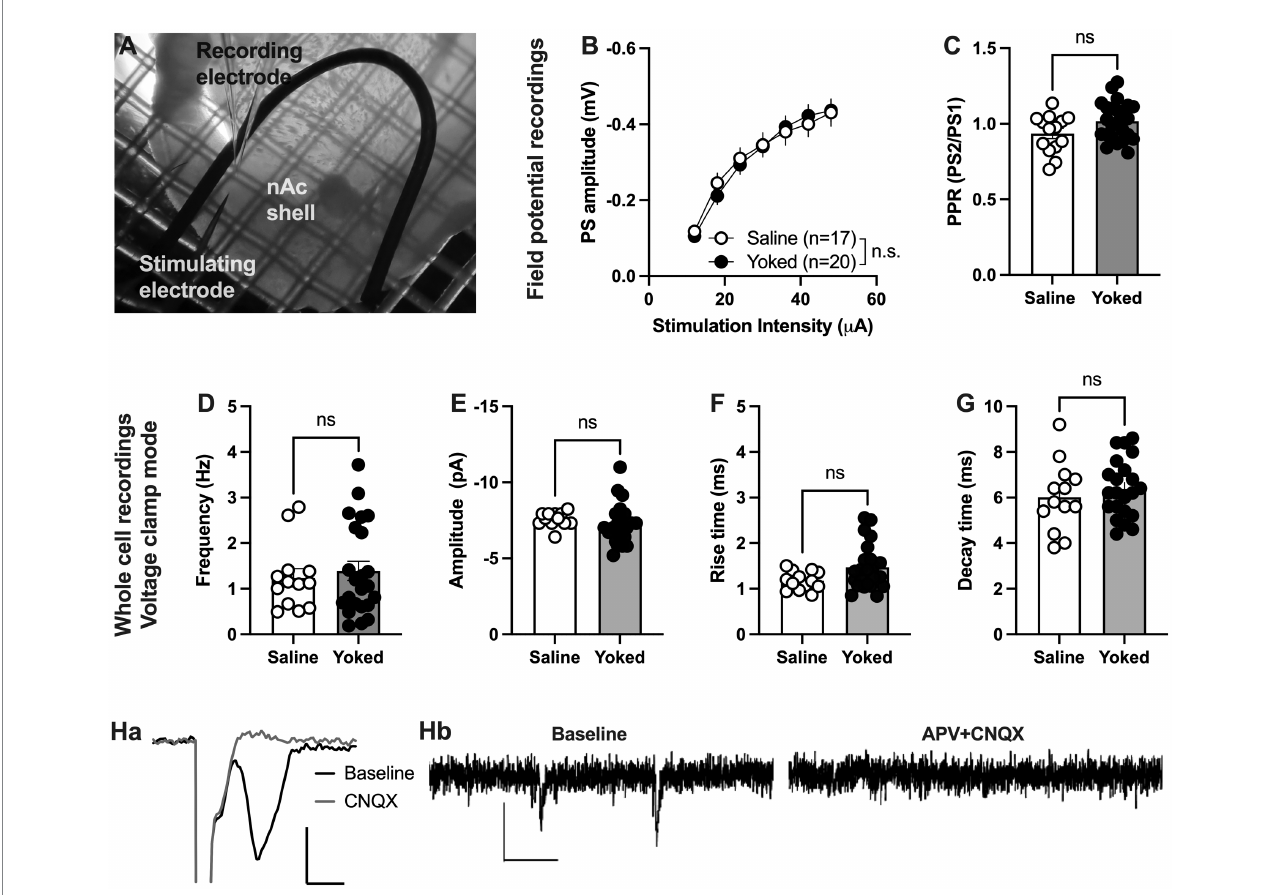
FIGURE 2 Neuronal transmission is not significantly altered in the nAcS of animals self-administering saline. (A) Micrograph showing the region of recording. (B,C) Evoked PS amplitudes were not significantly modulated by saline-self-administration, even though there was a trend toward increased PPR in brain slices from yoked-saline rats. (D–G) Whole cell recordings conducted in voltage clamp mode showed no effect by saline self-administration on neither frequency nor amplitude of spontaneous events. (H) Both evoked field potentials and sEPSCs were rapidly blocked by bath perfusion of CNQX and APV indicating that recorded activity is excitatory. Calibration: Ha: 2 ms, 0.2 mV. Hb: 50 ms, 10 pA. Values are presented as mean (±SEM), n = number of slices, taken from at least four